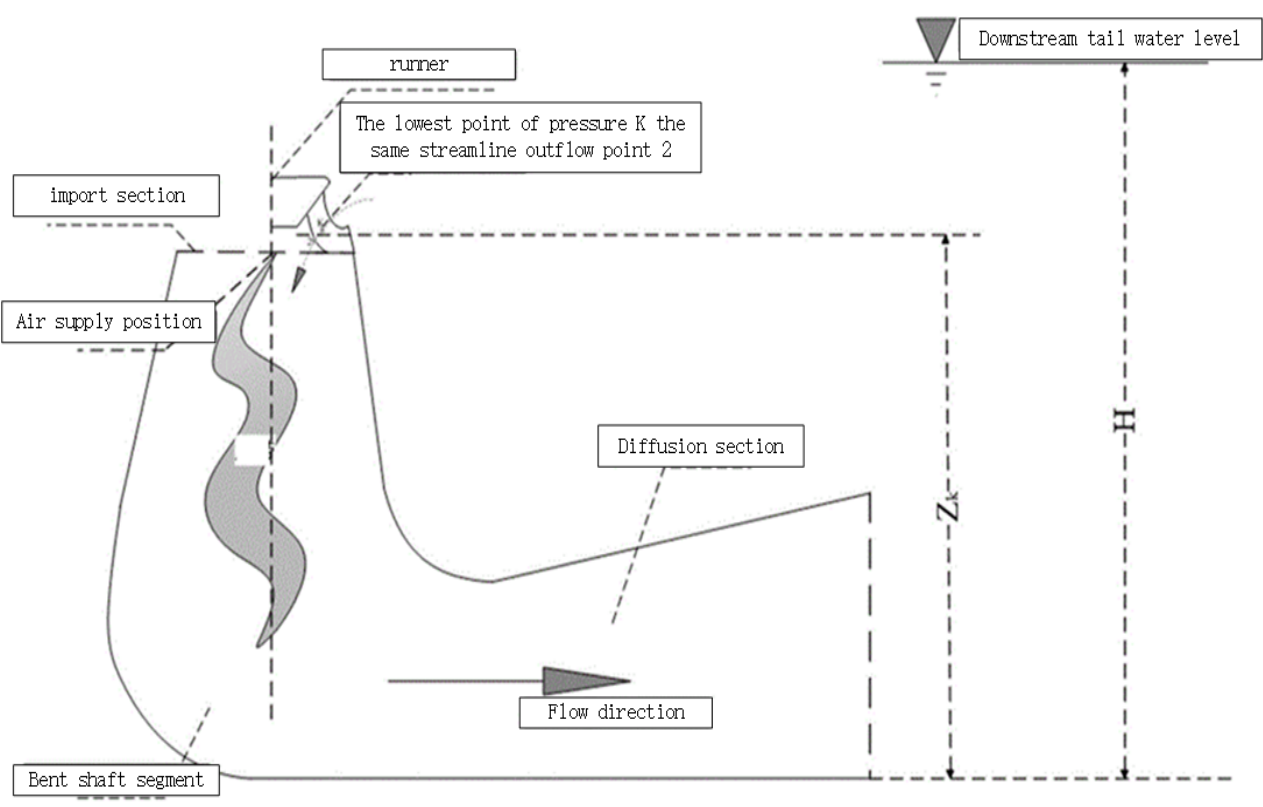
Figure 20. Schematic diagram of air injection [50].